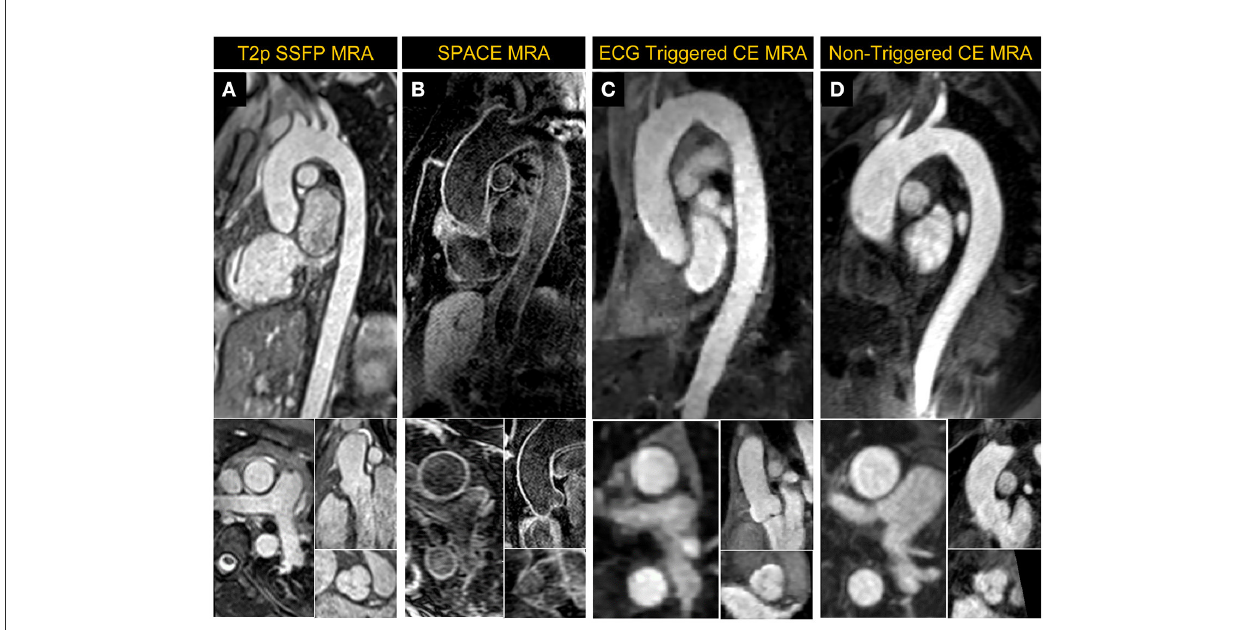
FIGURE9 Magnetic Resonance Angiography (MRA) images acquired at 0.55T. (A) 2D reformatted images from ECG-triggered, navigator-gated, GRAPPA-based 3D non-contrast MRA acquired in a healthy volunteer, (B) dark-blood 3D SPACE MRA images in a patient with dilated mid ascending aorta and having wires in the thoracic vertebrae post-spinal fusion, (C) a compressed sensing-based ECG-triggered contrast enhanced 3D MRA in a healthy volunteer and (D) non-gated contrast-enhanced MRA images acquired in a large patient with a mildly dilated thoracic aorta. The patient in (D) was unable to fit comfortably and proceed with the exam on a standard scanner but successfully completed a CMR exam on the 0.55T